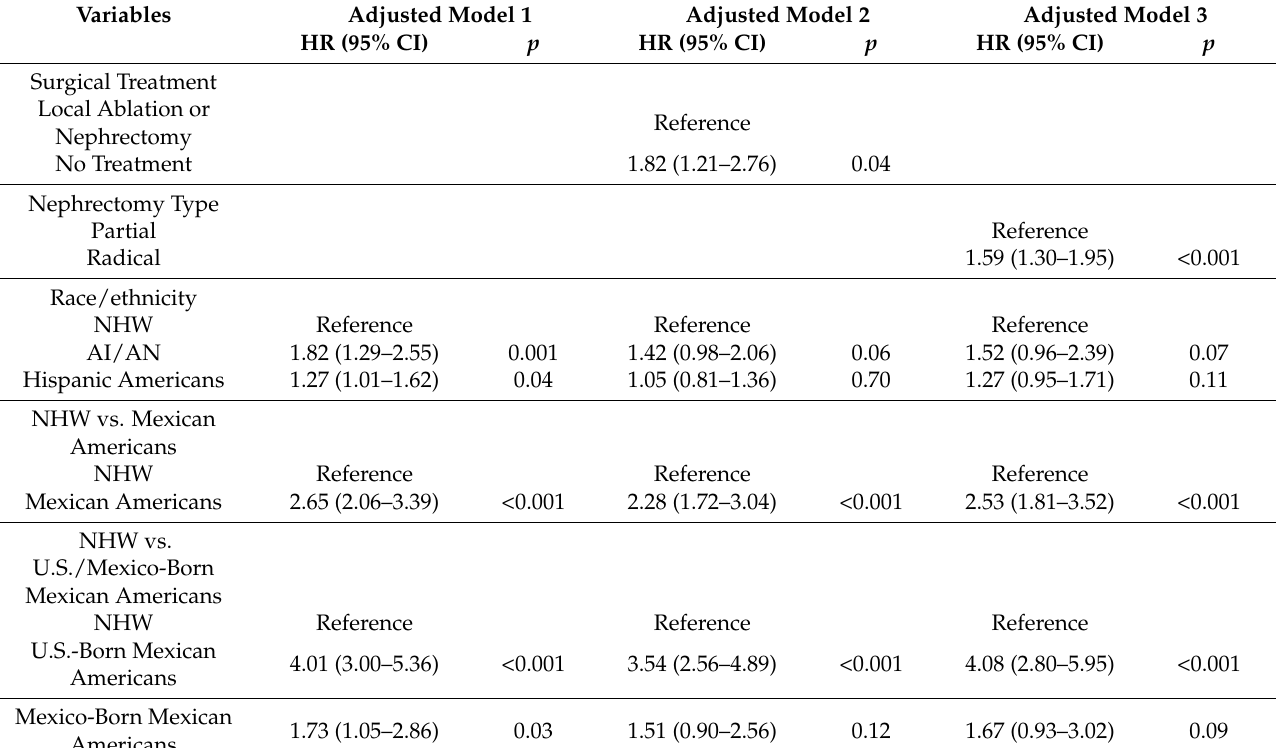
Model 1: Adjusted for age category, sex, marital status, RCC subtypes (excluding NOS), grade (1 and 2 vs. 3 and 4), diagnosis year (categorical); Model 2: Model 1 + % high school graduation., % poverty, and no surgical treatment vs. treatment; Model 3: Model 2 + % high school graduation., % poverty, and radical vs. partial